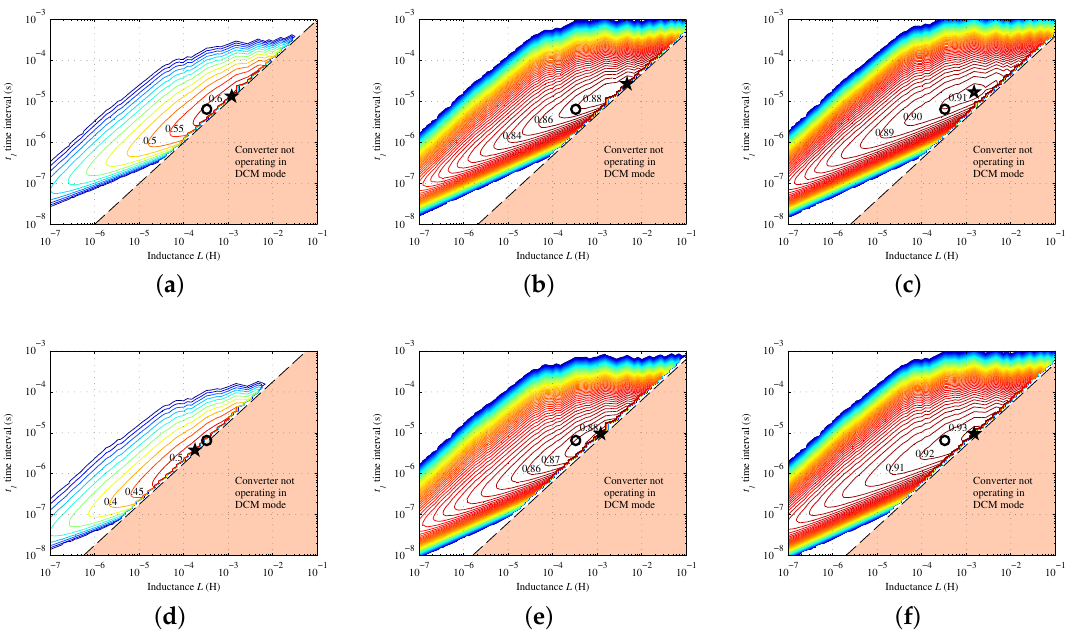
Figure 7. Simulation results of the efficiency performance of the converter for the a wide range of operating conditions ( V O and P IN ). ( a ) (0.5V, 2.0mW); ( b ) (2.0V, 2.0mW); ( c ) (3.5V, 2.0mW); ( d ) (0.5V, 9.8mW); ( e ) (2.0V, 9.8mW); ( f ) (3.5V, 9.8mW). The maximum efficiency point is